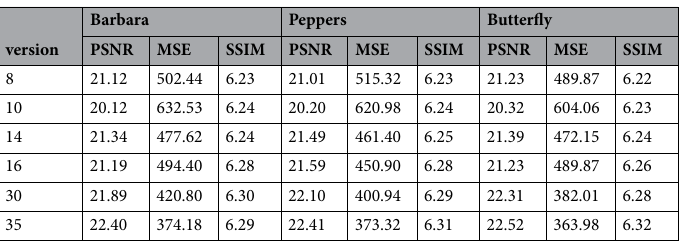
Table 1. The performance of the proposed scheme for three secret images.